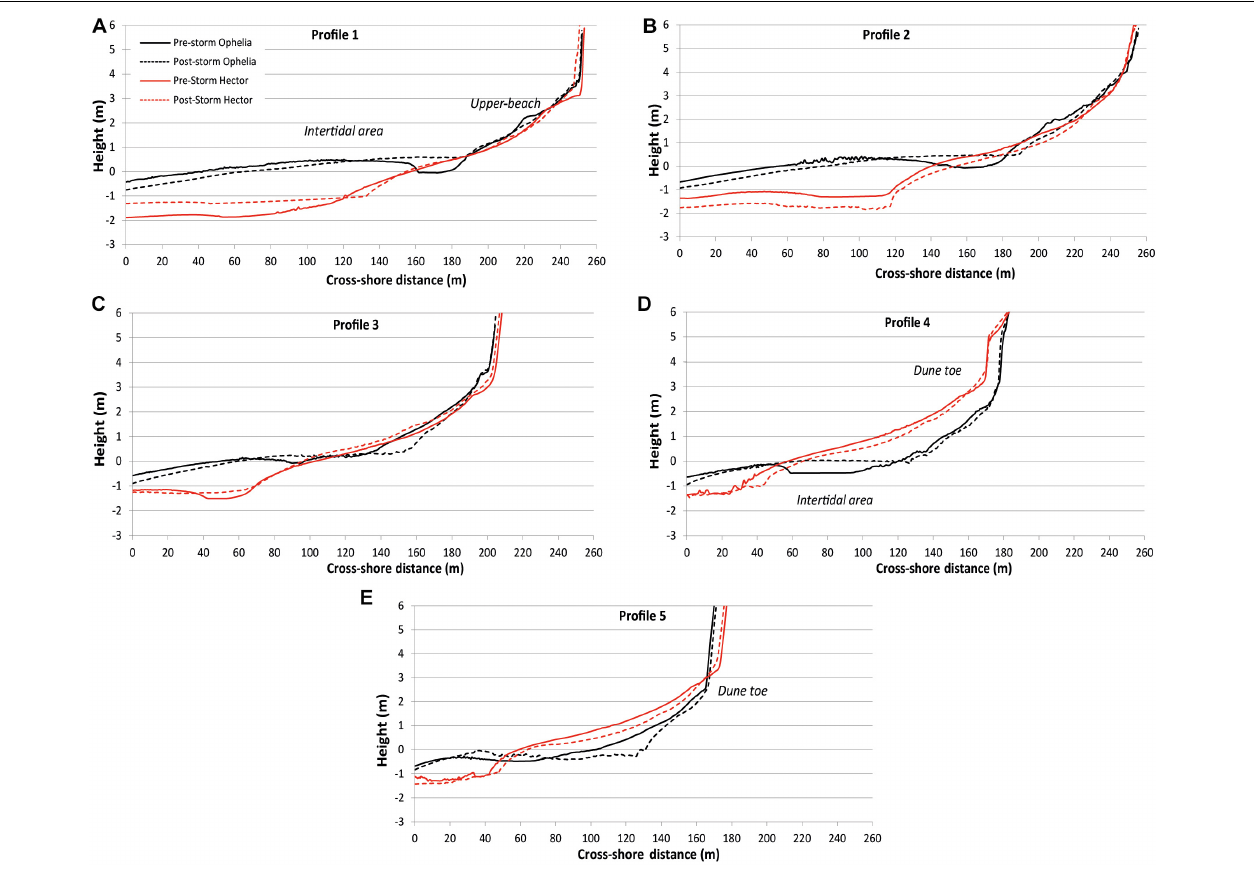
FIGURE 8 | Diagrams (A–E) correspond to five cross-shore profiles used to compare topographic changes (see Figure 1B ). Pre-Storm Ophelia is represented by the black line and post-Storm with a black dashed line. Red line corresponds to pre-Storm Hector and the post-Storms profile is shown with a dashed red